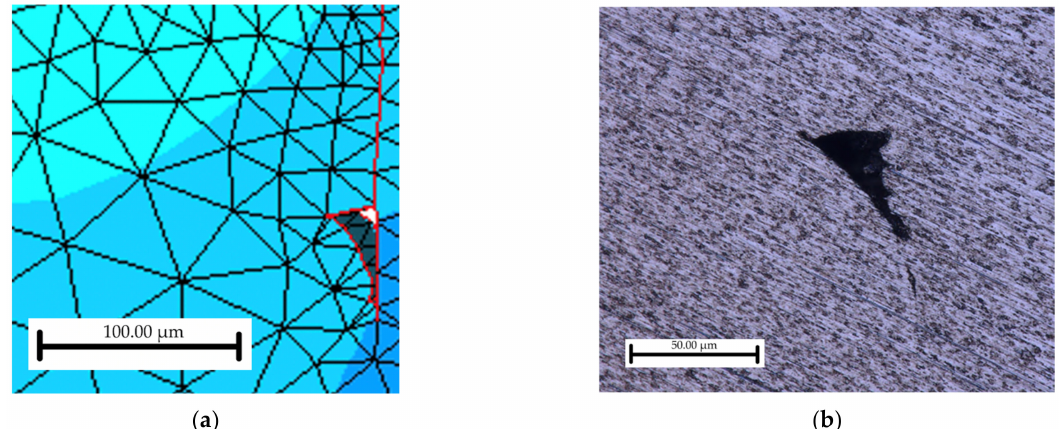
Figure 15. A visualization of the void in the material caused by volumetric kinematics. ( a ) The void in the model; ( b ) The void in the welding process.